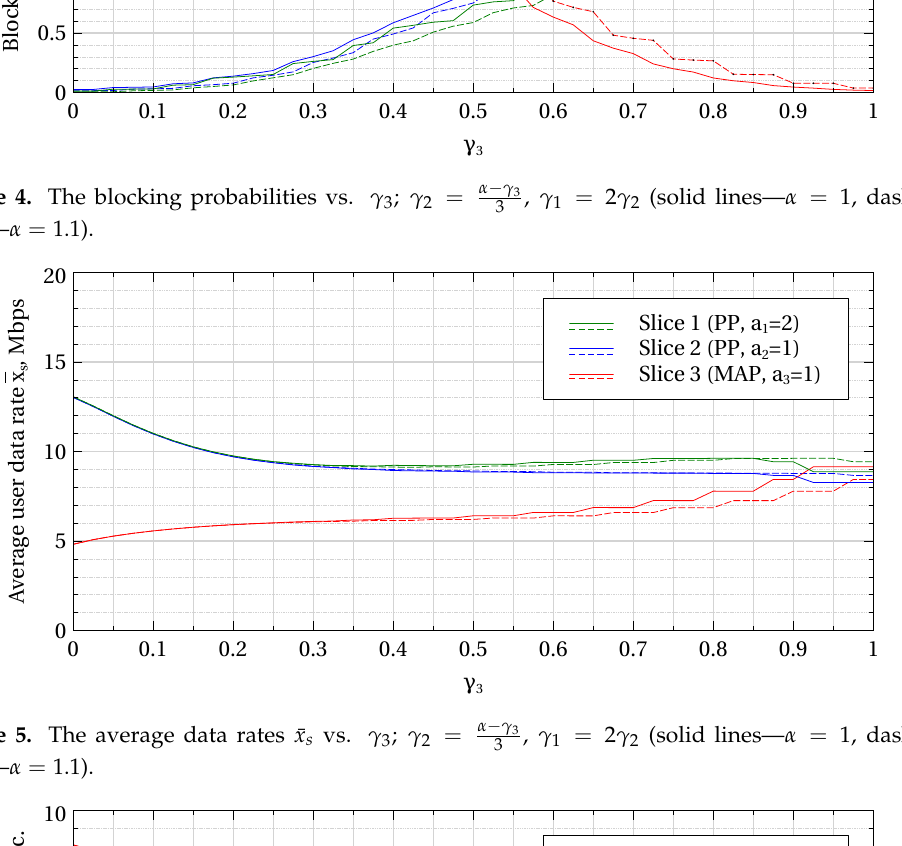
, γ 1 = 2 γ 2 (solid lines— α = 1, dashed 3